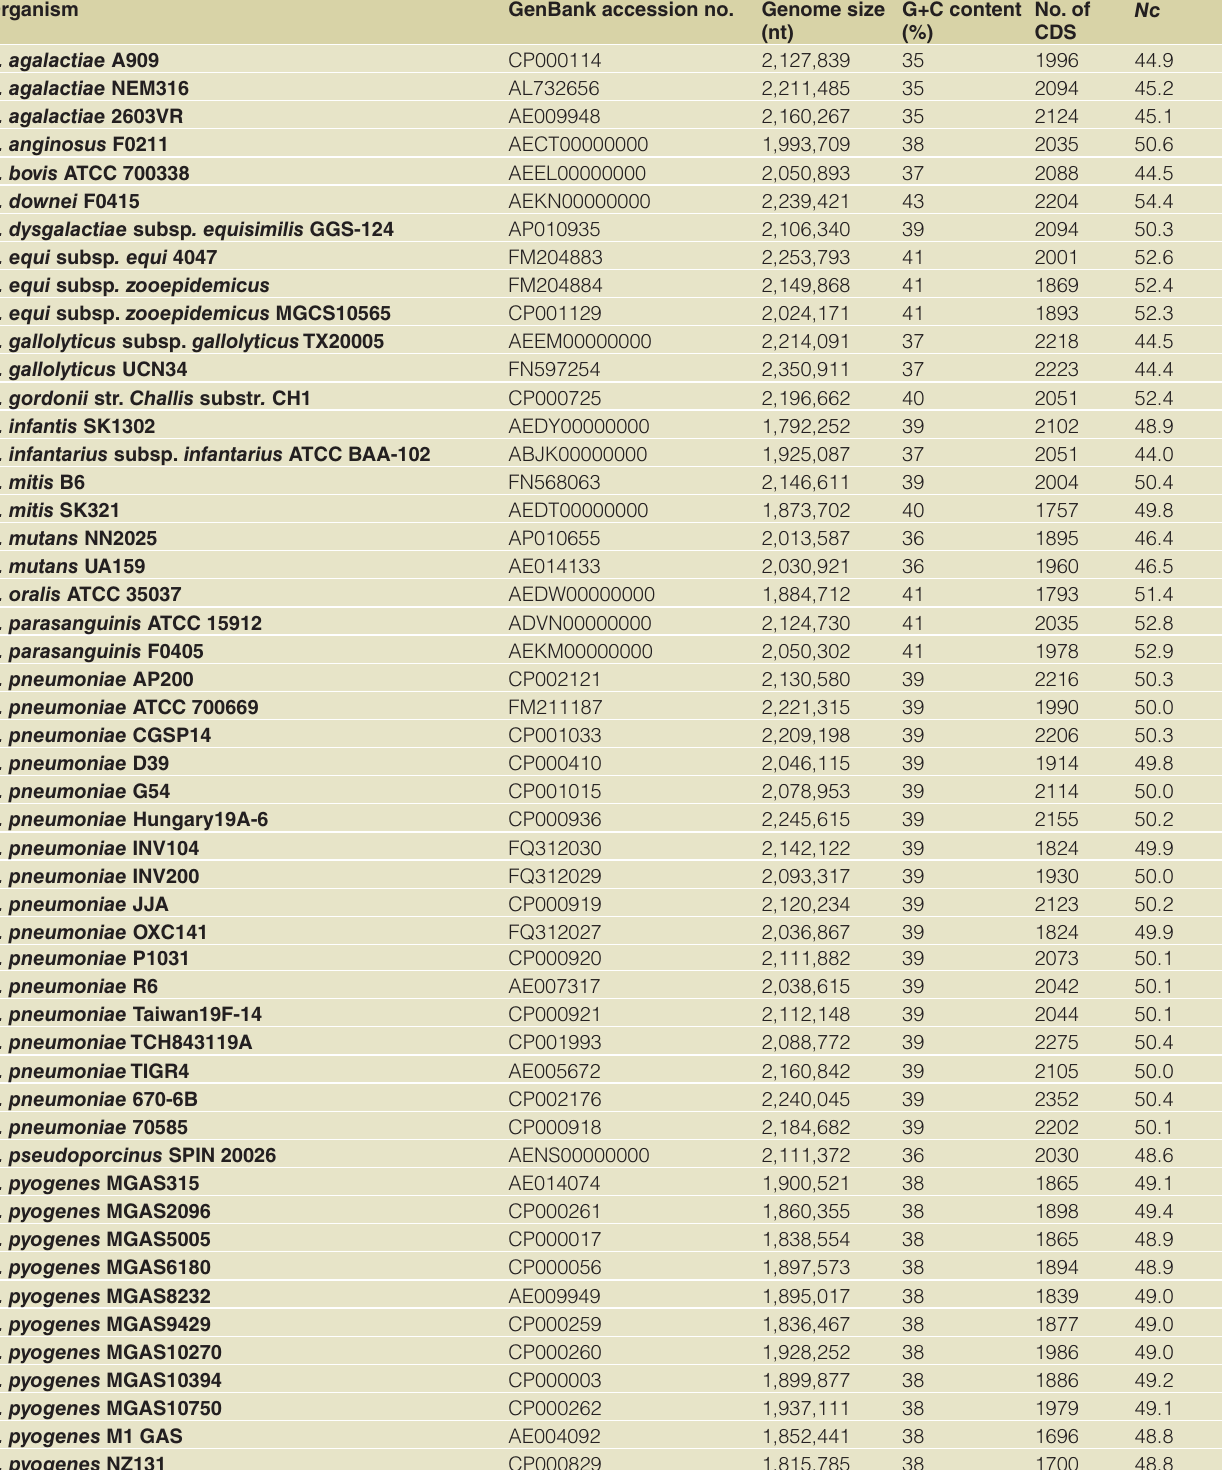
Table 1. Genomic features of the streptococci. G+C content (%): guanine + cytosine content (%). No. of CDs: number of coding DNA sequence. Nc : effective number of codons.